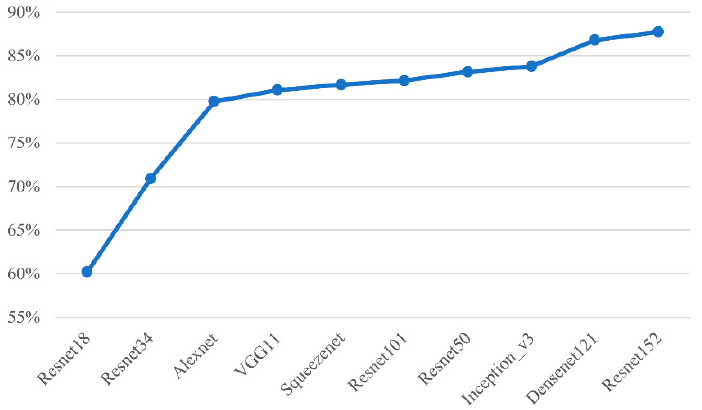
Figure 17. Accuracy results (from K-fold cross validation) on forehead wrinkles plotted across sev-